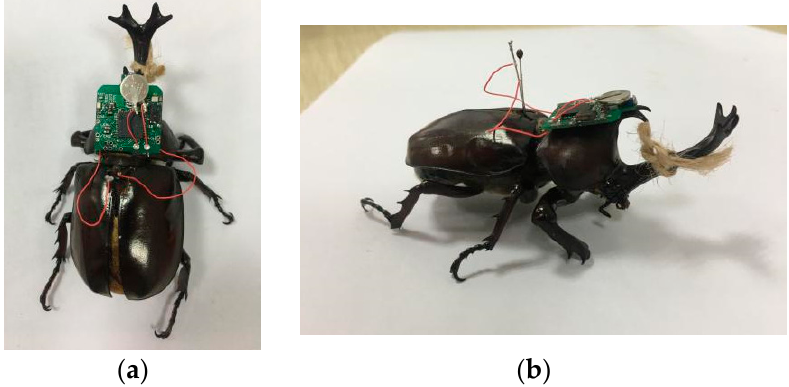
Figure 5. Photograph of a beetle carrying an electronic backpack. ( a ) The top view of the beetle; ( b ) the side view of the beetle.